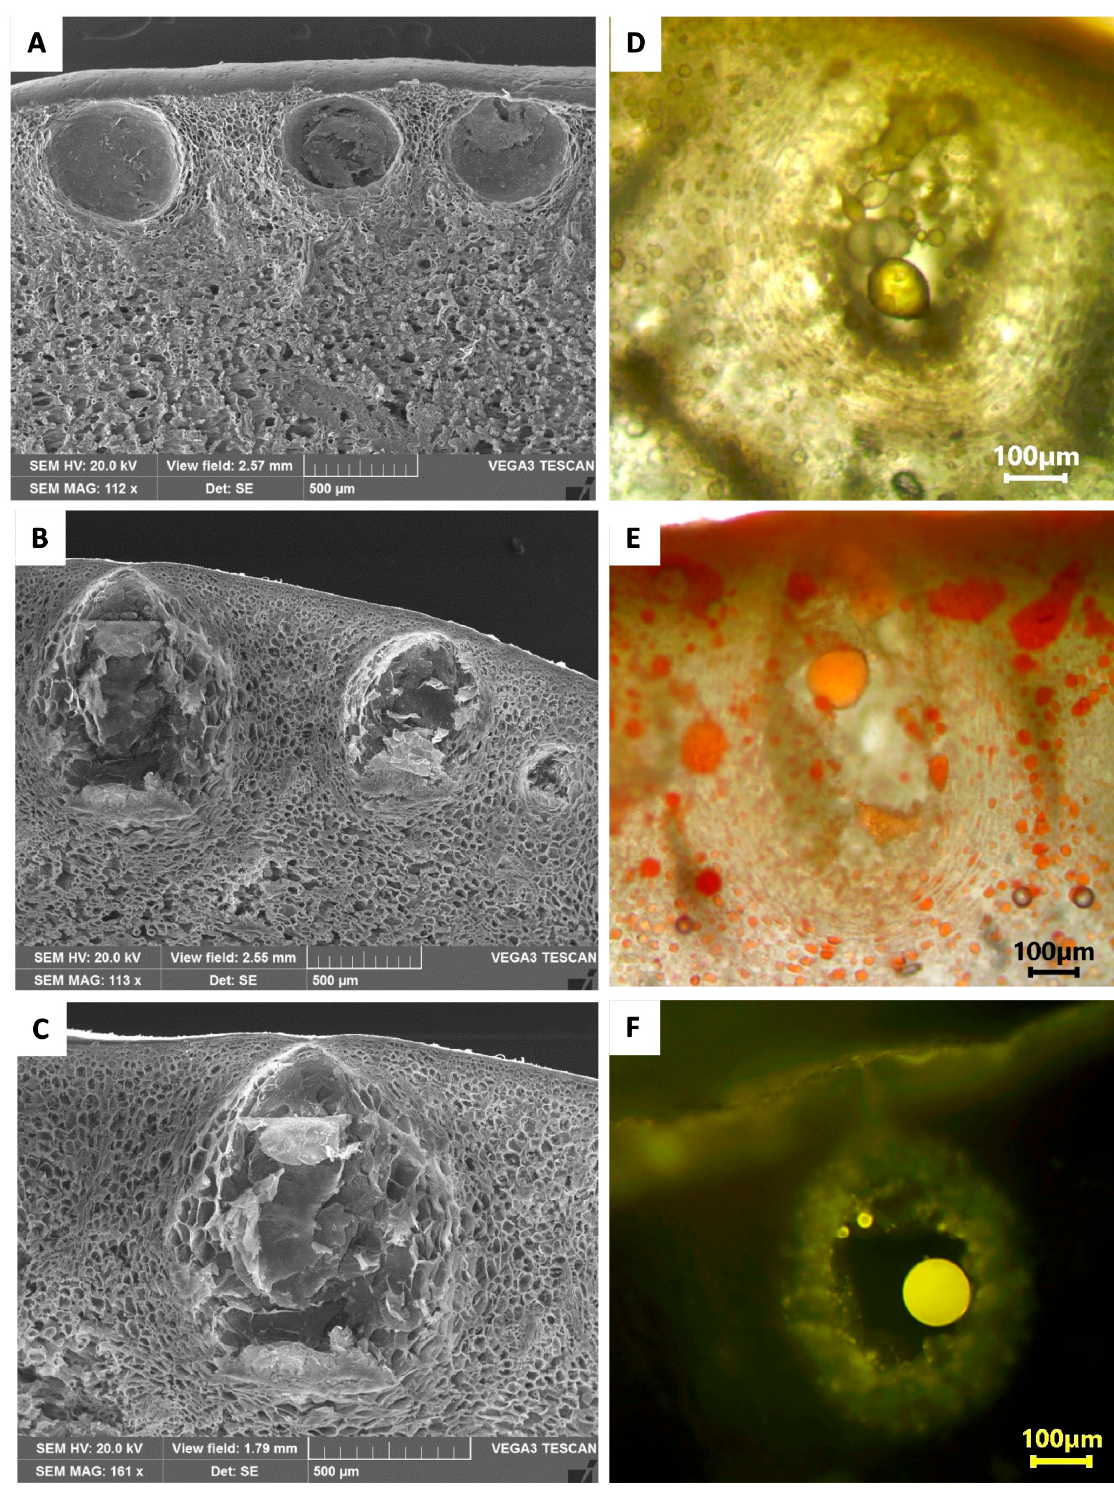
Figure 2. Micrographs of the fruit peel of C. lumia ‘Pyriformis’ obtained using SEM ( A – C ) and light ( D – F ) microscopy. ( A – C ): spherical ( A ) to ellipsoidal/pyriform ( B , C ) oil cavities visible in a fruit peel cross section. ( D – F ): Deposits of the EO visible within the secretory cavities: ( D ) EO droplets without histochemical staining; ( E ) droplets of the EO stained orange-red by Sudan III; ( F ) brilliant yellow fluorescence of the EO drops stained with Fluorol Yellow 088.